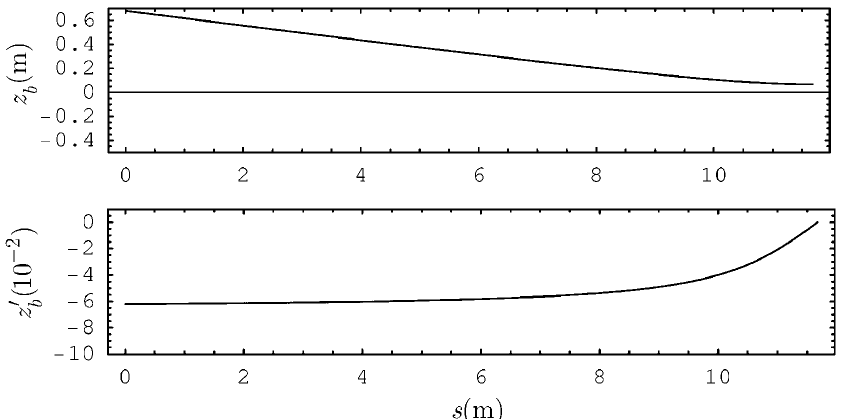
FIG. 5. Longitudinal drift compression of an IBX beam pulse.